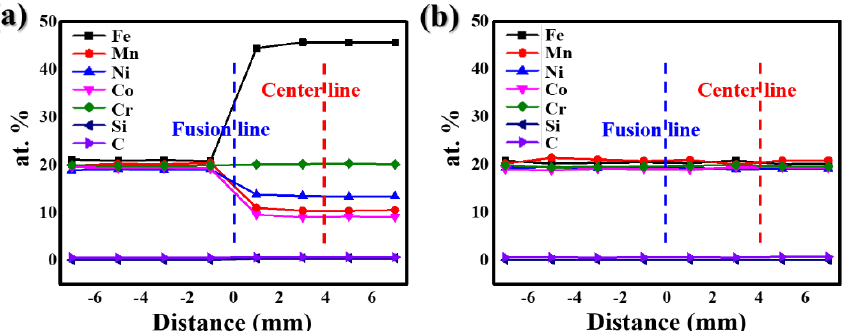
Figure 3. Compositional behaviour of GTA welds produced using various fillers: ( a ) STS 308L and ( b ) HEA.